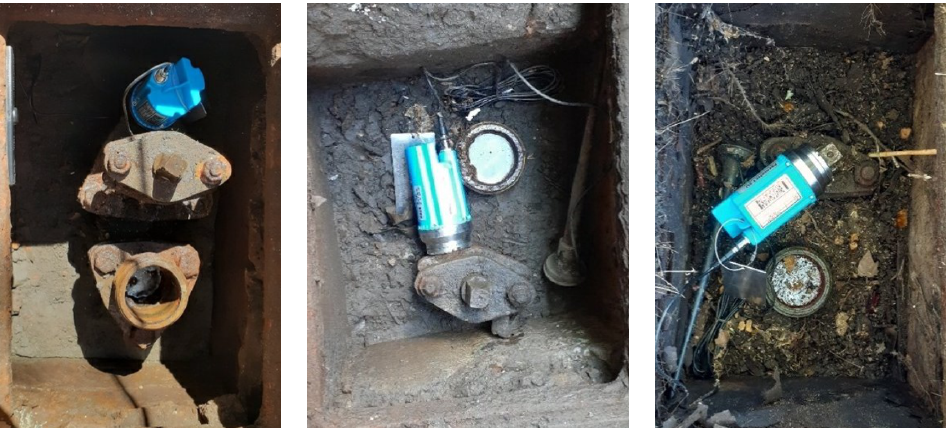
Figure 2. HWM PermaNET SU loggers deployed on hydrant control valves in different